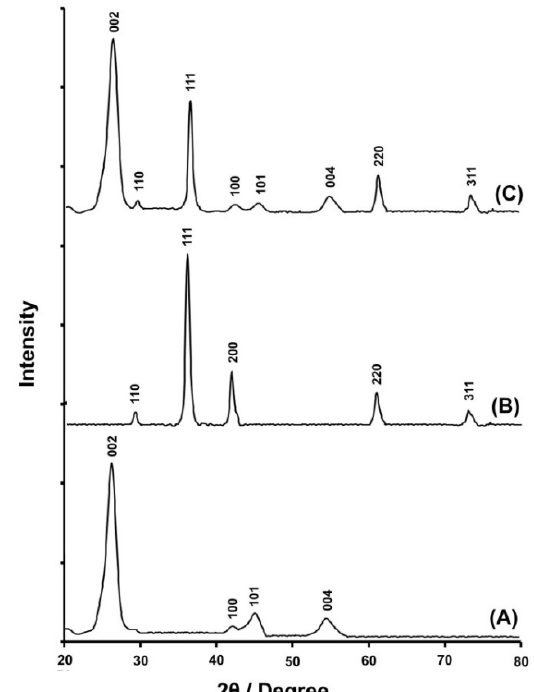
Figure 2. XRD patterns of: ( A ) bare graphite grains, ( B ) pure synthesized Cu 2 ONPs–C and ( C ) Cu 2 ONPs–C@G.